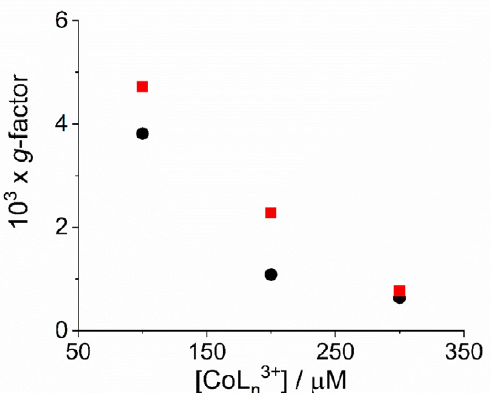
Figure 6. Plot of dissymmetry g -factor for the fully aggregated samples as function of the concentration of the complex metal ions [Co(phen) 3 ] 3+ (circles) and [Co(NH 3 ) 6 ] 3+ (solid squares). (Experimental conditions: [H 2 TPPS 4 ] = 3 µM; [HCl] = 0.01 M, T = 298 K).